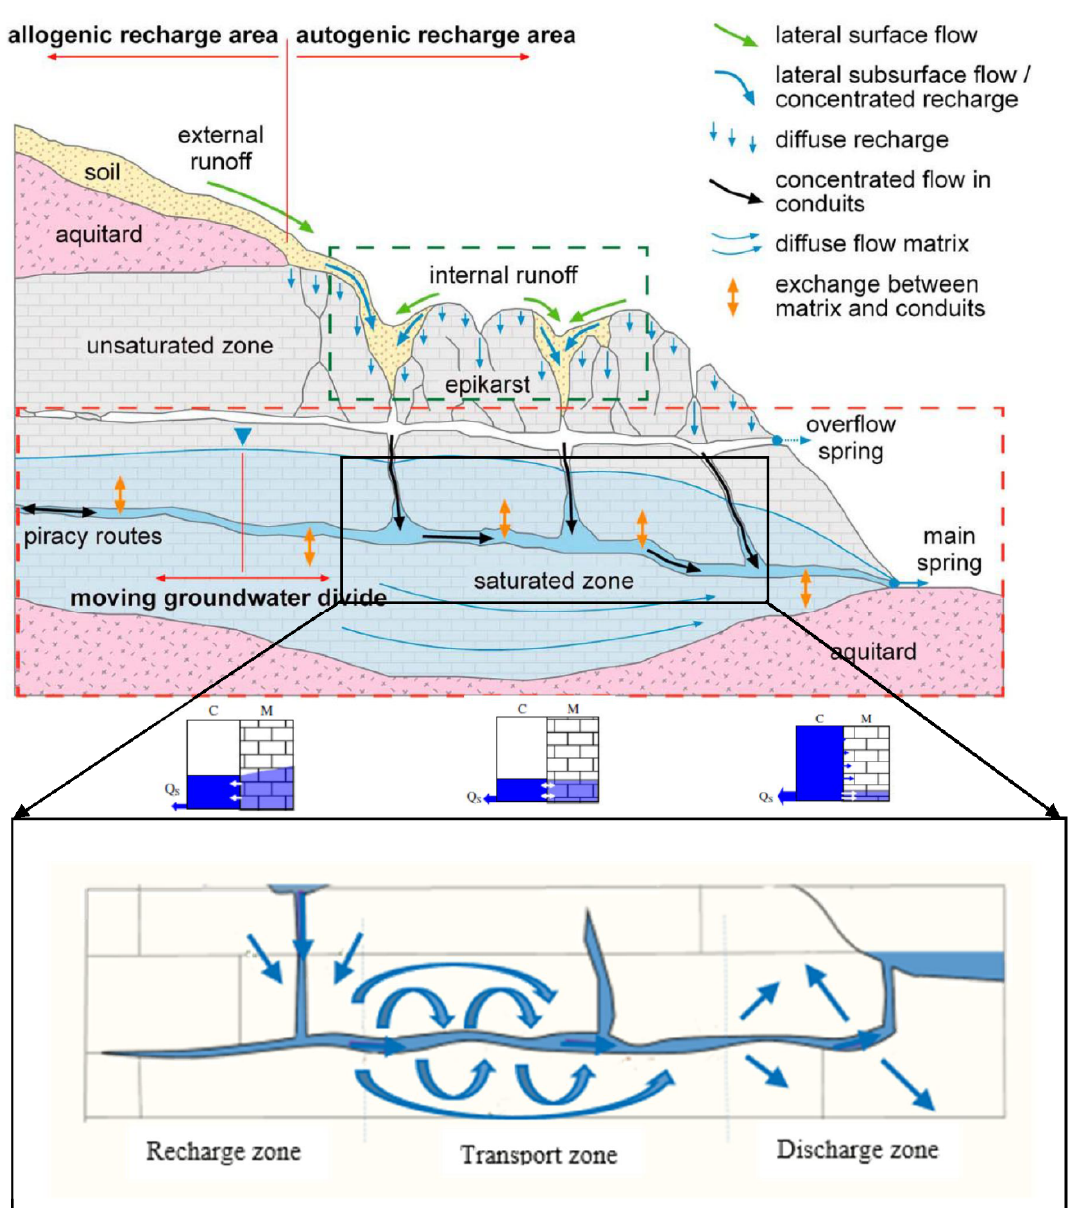
Figure 1. Conceptual model of flow in the karst aquifer with the dual-porosity (modified from Bailly-Comte et al. [ 16 ], Hartmann et al. [ 3 ], Binet et al. [ 33 ] ).